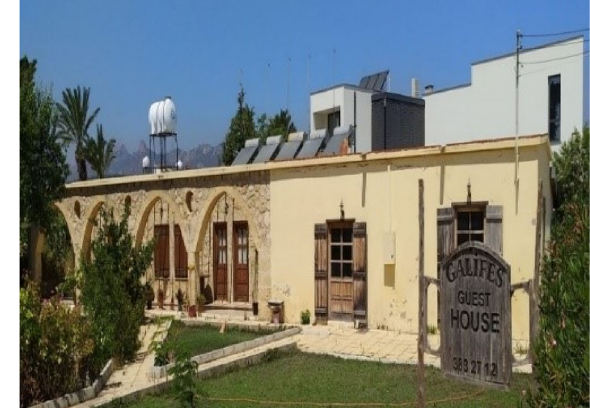
Fig. 13 Galifes Guest House. An example of a structure built with stone material — Komikebir.